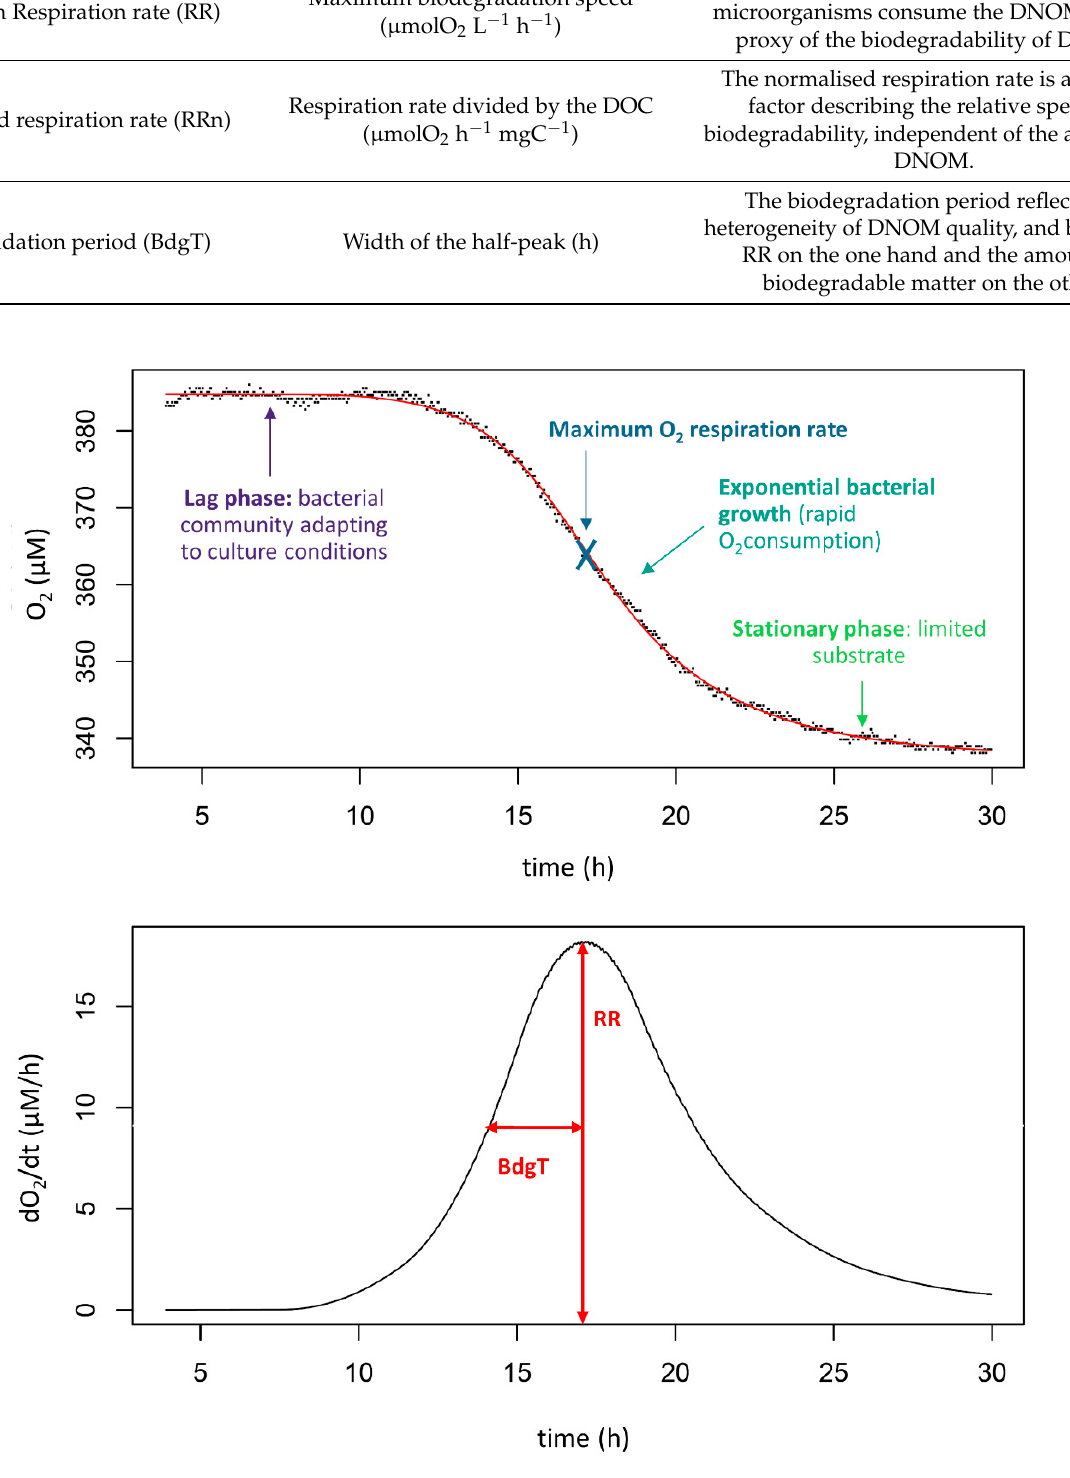
Figure 3. Typical O 2 concentration curve (top panel) and corresponding derivative (bottom panel). RR is the respiration rate and BdgT is the biodegradation Period (see Table 1).